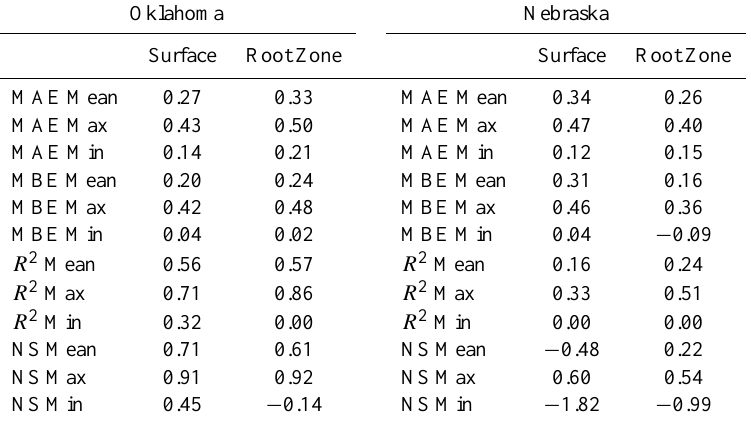
Table 3. Statistics showing the correspondence of SMOS and station SWI data sets. Values under surface are calculated from station surface– SMOS surface while values under root zone are calculated from station root zone – SMOS root zone. Table shows the mean, maximum and minimum over all sites. All values are SWI unitless.